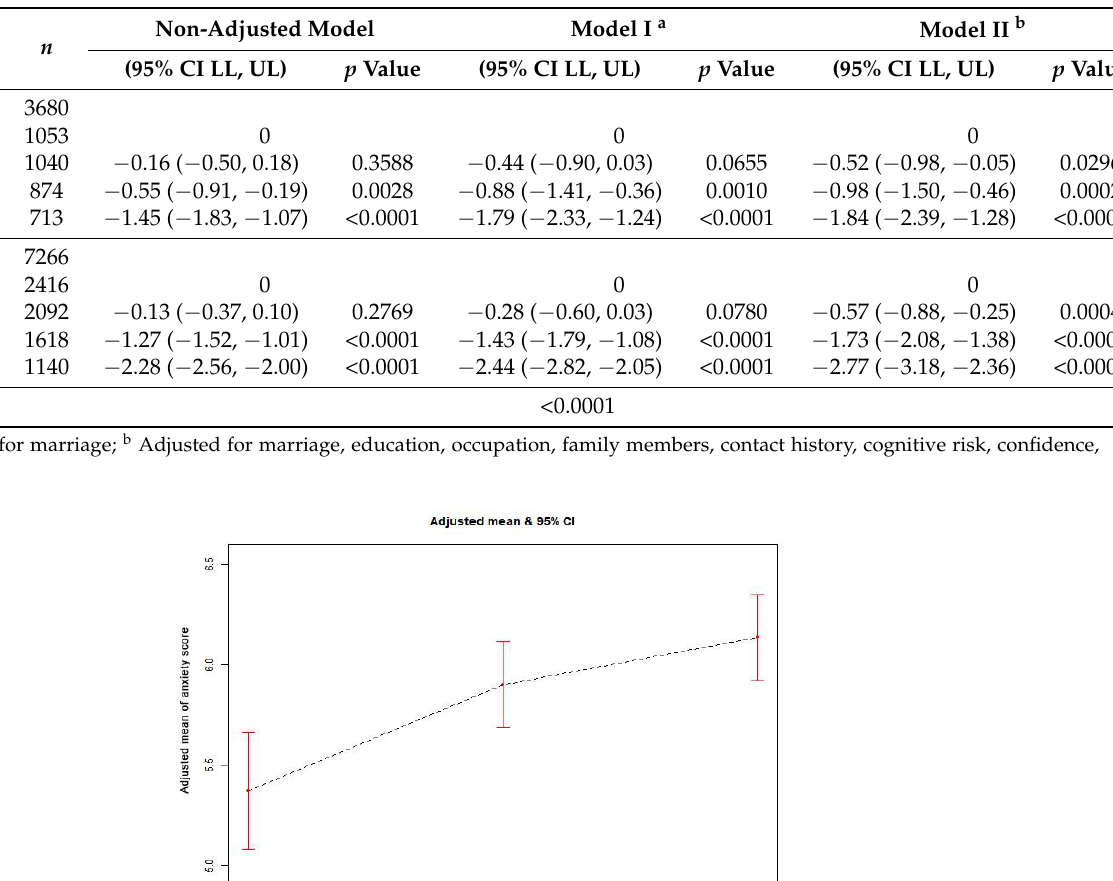
Table A1. The association between age and anxiety score, stratified by hierarchy.